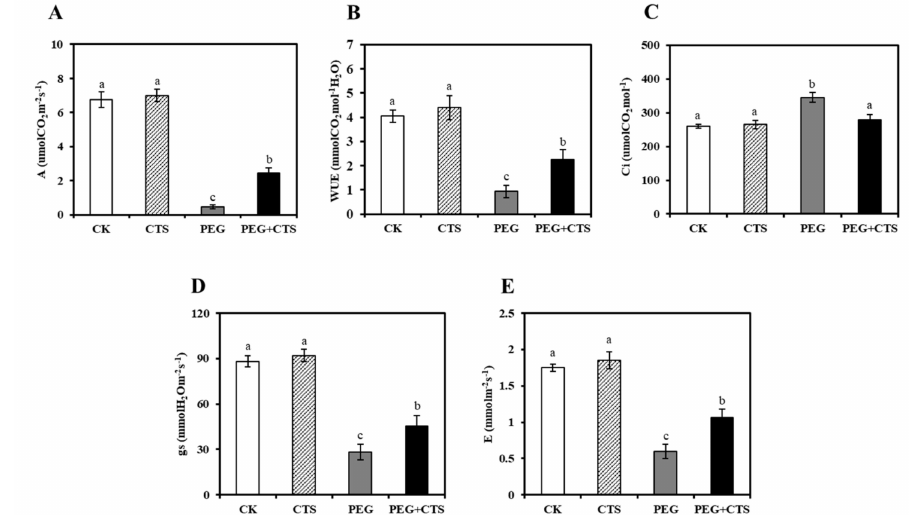
Figure 4. E ff ect of chitoscan (CTS) pre-treatment on photosynthetic characteristics net photosynthetic rate ( A ), water use e ffi ciency ( B ), intercellular CO 2 concentration ( C ), stomatal conductance ( D ), and transpiration rate ( E ) of annual ryegrass su ff ered from osmotic stress. Vertical bars represent mean values ± SD for each mean. Di ff erent letter indicates significant di ff erences at given day ( P ≤ 0.05). 3.5. The Expression of Antioxidant Enzyme-Related Genes and Proline Biosynthetic Gene P5CS1 were A ff ected by Exogenous CTS